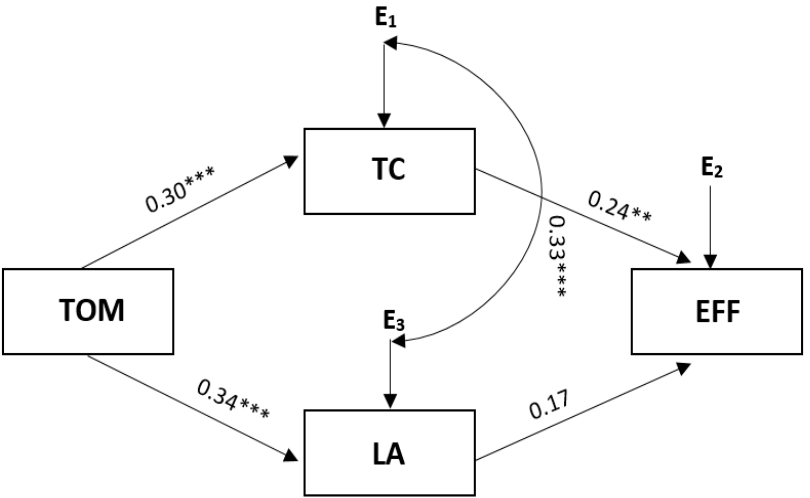
Figure 1. The summarising model for task orientation and styles of coping with stress. Note. Chi 2 = 0.286; df = 1; p = 0.593; CFI model = 1.00; RMSEA = 0.001; indirect effect for task motivation =